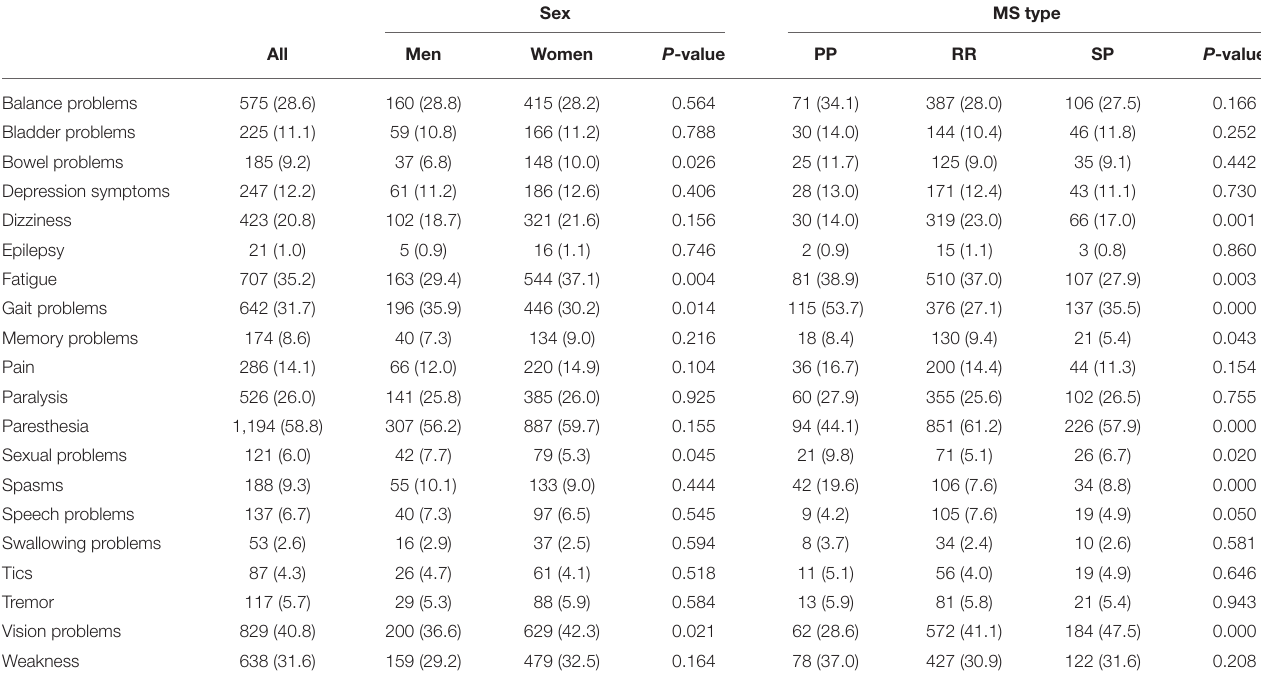
TABLE 1 | Frequencies of MS onset symptoms (%) in the Swiss Multiple Sclerosis Registry; overall, by sex and by MS type; p -values after χ 2 -test. Sex MS